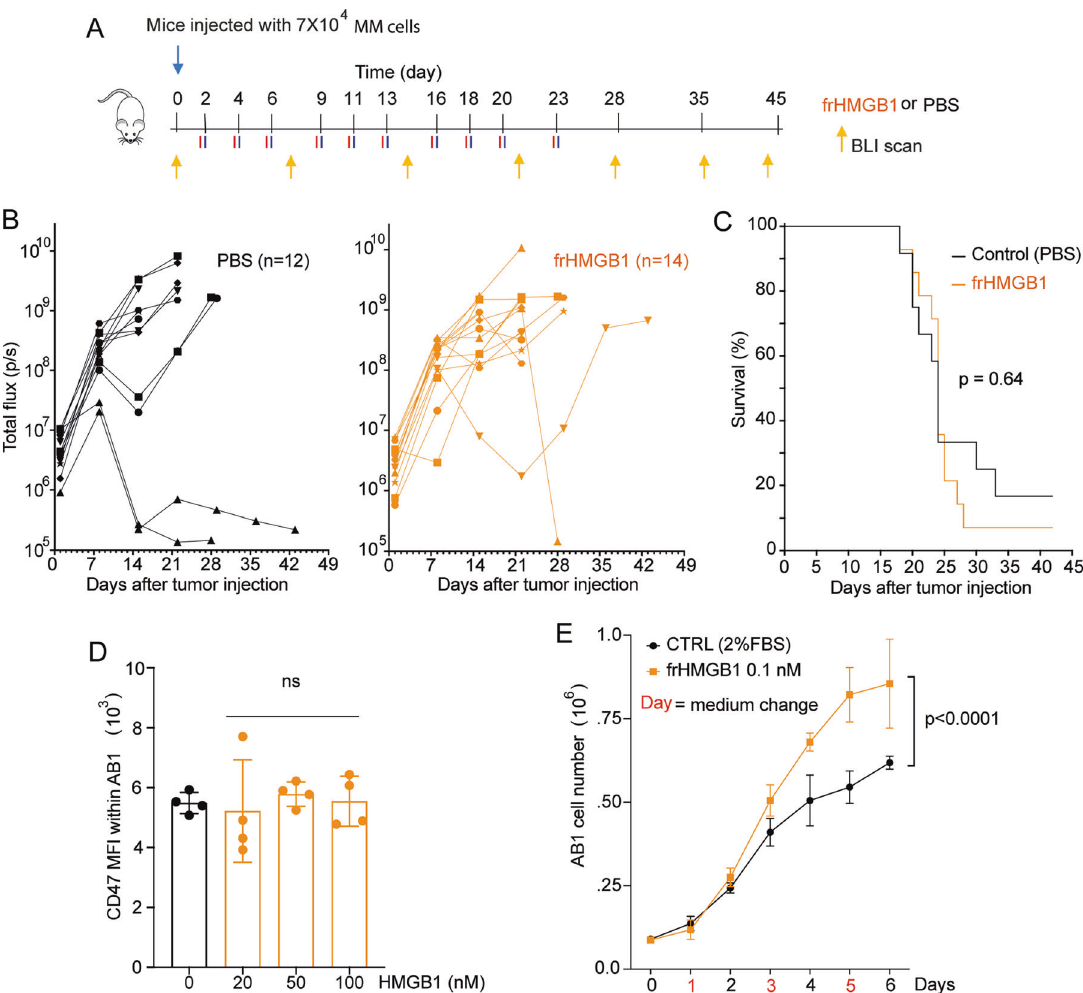
μ g of frHMGB1 (HMGBiotech, Milano) or PBS (control) were injected i.p. three times a week and bio-luminescence imaging (BLI) scans were performed once a week. B Tumor growth, as monitored by BLI, was similar in control and frHMGB1-treated mice. C Survival curves of HMGB1- injected and control mice were not signi fi cantly different. Statistics: log-rank Mantel-Cox test. D Surface CD47 on MM cells was evaluated by fl ow cytometry after incubation for 24 h with the indicated concentrations of frHMGB1. The experiment shown is representative of the two performed. Error bars indicate standard deviation. Statistics: one-way ANOVA. ns = not signi fi cant. E frHMGB1 was added to the culture medium of 10 5 AB1-B/c-LUC cells seeded in 6-well plates (starting at day 1). Cells were counted every day for 6 days. Statistics: two- way